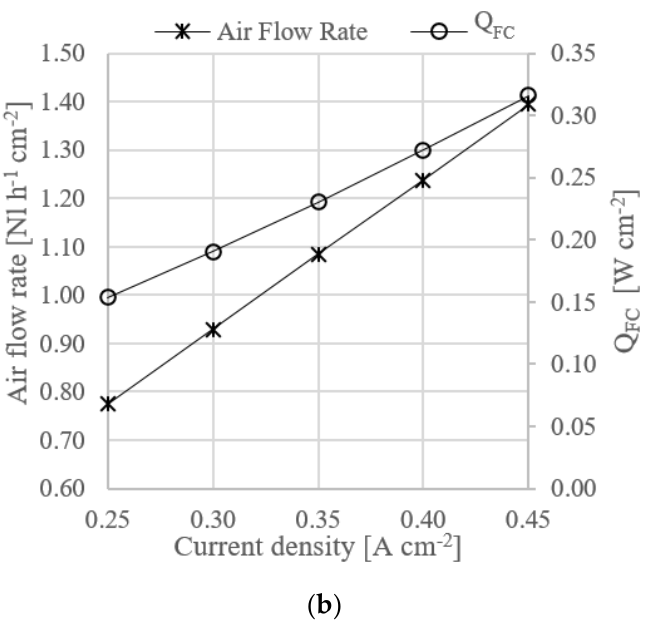
Figure 7. ( a ) Power density and system efficiency as function of current density. ( b ) Air flow rate and heat generation in the fuel cell as a function of current density.